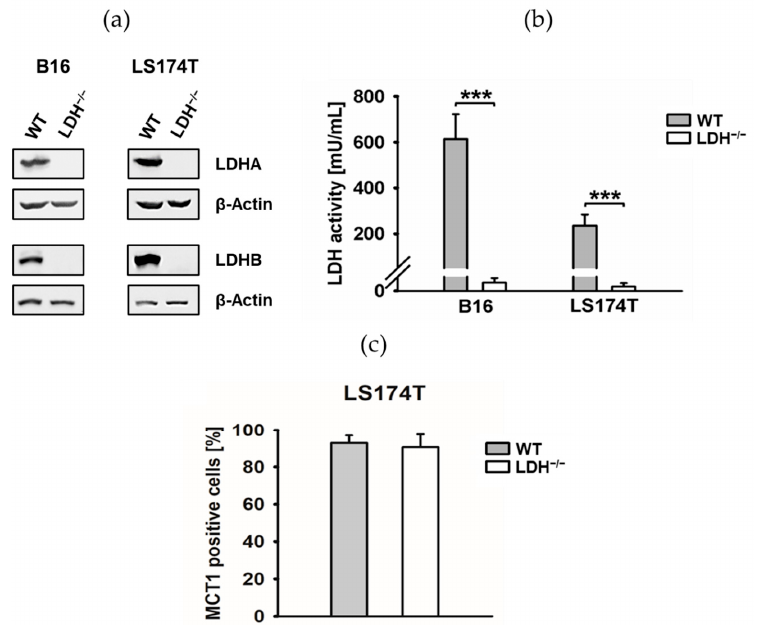
Figure 2. LDHA/B double knockout and its effect on lactate dehydrogenase (LDH) activity. ( a ) Representative immunoblot showing the successful double knockout of LDHA and LDHB (referred to as LDH − / − ) of mouse B16F10 and human LS174T tumor cell lines. β -Actin was used as a loading control. ( b ) The effect of LDHA/B double knockout on LDH activity in B16F10 and LS174T cells (***: p ≤ 0.001). ( c ) Flow cytometric analysis of the lactate transporter MCT1 using MCT1-APC mAb on LS174T WT and LDH − / − cells. The proportion of positively stained cells is shown. Error bars show the standard deviations of at least three biological replicates. Full Western blot images are available in Figure S5. Similar to the results obtained with LDH inhibitors, a LDHA/B double knockout re- duced the cytosolic Hsp90, Hsp70 and Hsp27 levels in B16F10 and LS174T cells, although the Hsp27 levels could not be detected in B16F10 cells due to a very low Hsp27 expression in murine tumor cells (Figure 3a,b). Consistent with these findings, the expression of non- phosphorylated and phosphorylated Heat Shock Factor 1 (HSF1 and pHSF1, respectively) known to regulate the expression of Hsp70 and Hsp27 was also reduced by a LDHA/B double knockout in both tumor cell types (Figure S1a,b).